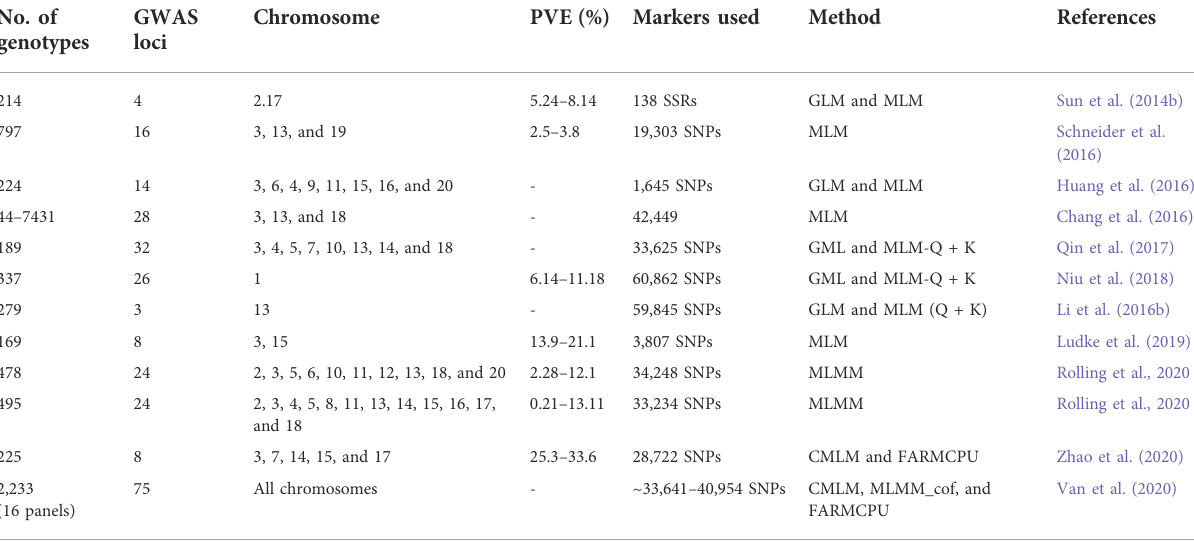
TABLE 3 Details of genomic regions associated with P. sojae resistance identi fi ed through the association mapping/GWAS approach in soybean. No. of